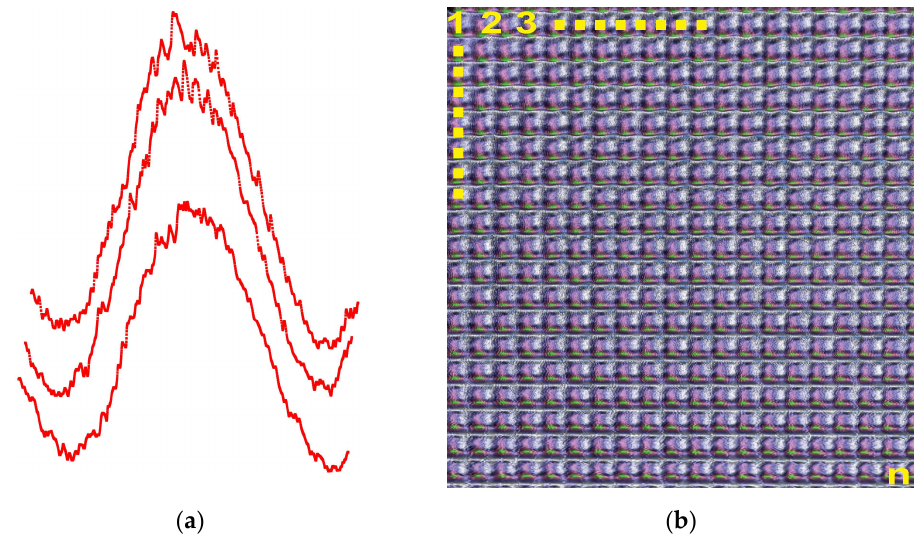
Figure 7. ( a ) Comparison of profiles of 3 dies for sorting criterion. ( b ) Image of all dies numbered